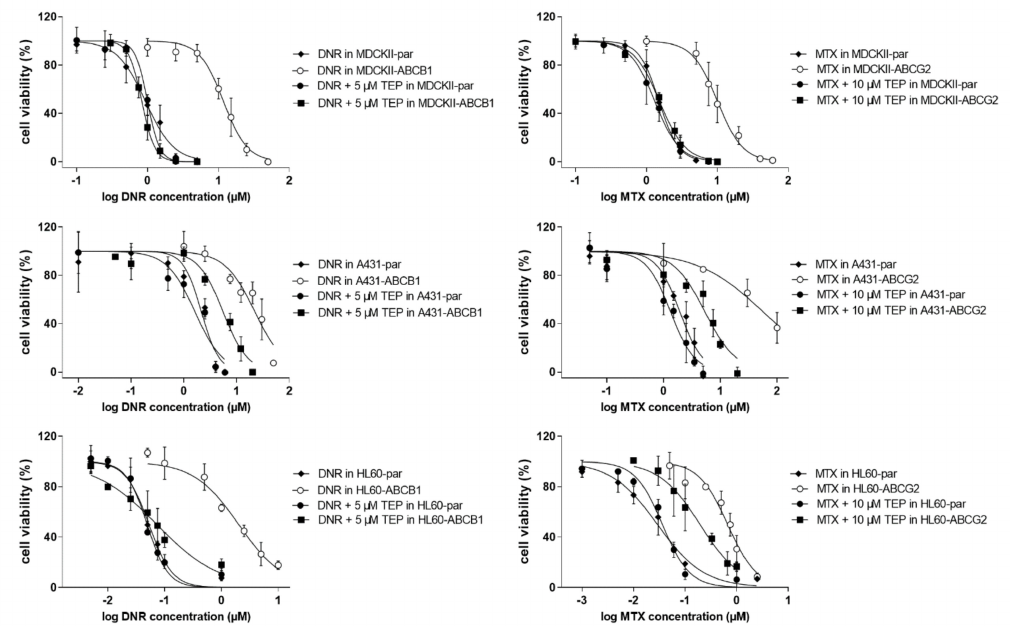
Figure 3. Tepotinib reverses daunorubicin and mitoxantrone resistance in vitro. Drug combinations were conducted using MTT/XTT proliferation test. Absorbance values from cells treated with vehicle-containing media and 40% DMSO in media were used as 100% and 0% viability controls for data normalization, respectively. DNR, daunorubicin; MTX, mitoxantrone; TEP, tepotinib.